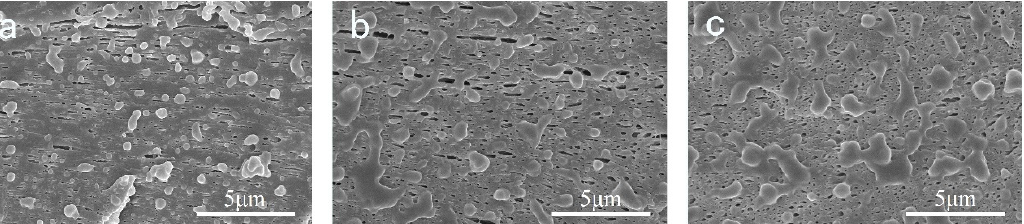
Figure 11. Morphology of dispersed EPDM in the printed samples of ( a )S-2; ( b ) S-3; ( c ) S-4. The magnification is 21,000.